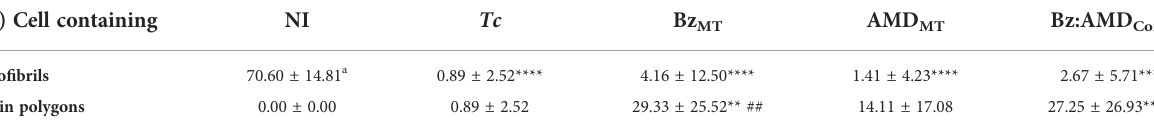
TABLE 2 Quanti fi cation of cytoskeletal remodeling in T. cruzi -infected HCs treated for 72 h with Bz and AMD in monotreatment or in combination. (%) Cell containing